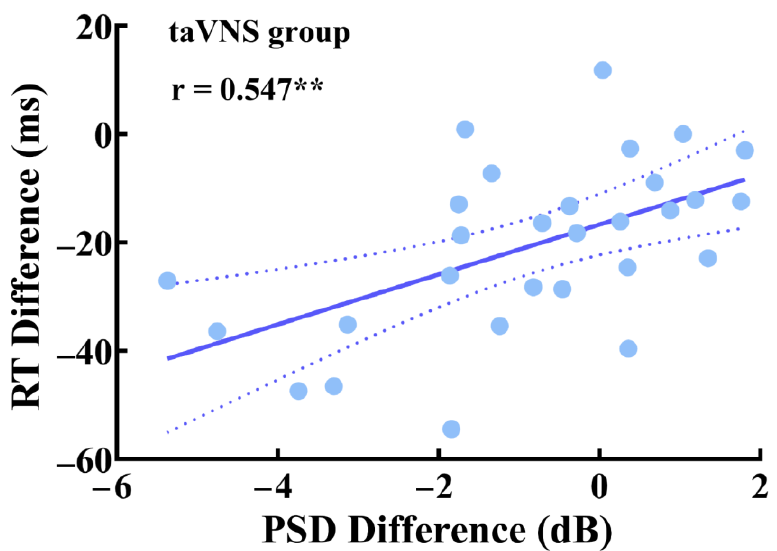
Figure 4. Partial correlation between the RT difference and the PSD difference of high- α oscillations in the taVNS group under the close-eye resting state. ** p < 0.01.